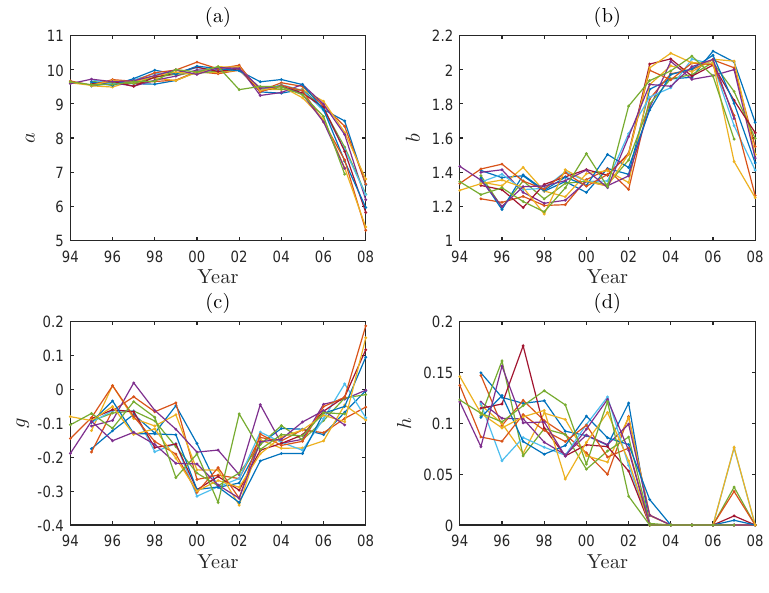
Figure 3. Time series plots of parameter estimates of the g-and-h model, where each panel corresponds to a parameter and each line within a panel corresponds to a month. The panels ( a ), ( b ), ( c ), and ( d ) correspond to the a , b , g , and h parameters,